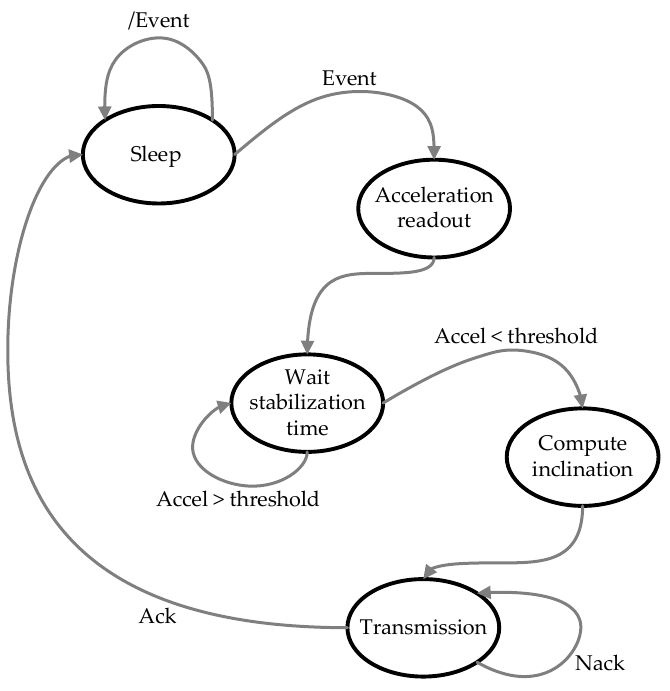
Figure 8. Sensing element processing flow.